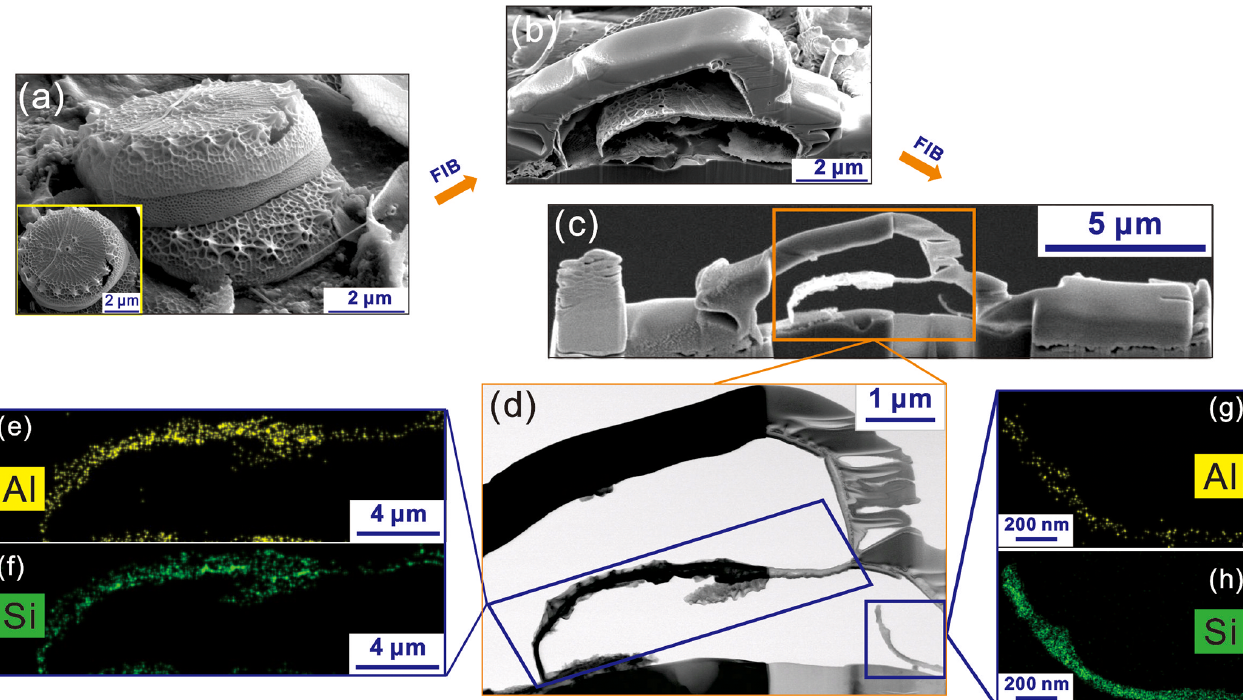
Figure 4. ( a and the inset) FESEM image of a T. weissflogii BSi; (b, c) FESEM images of a series of FIB milling products of the BSi during the ion sputtering experiments; (d) HRTEM bright field (BF) image of the selected domain in the rectangle in (c) ; (e, g) Al and (f, h) Si distributions in the domains in (d) obtained using EDS mapping